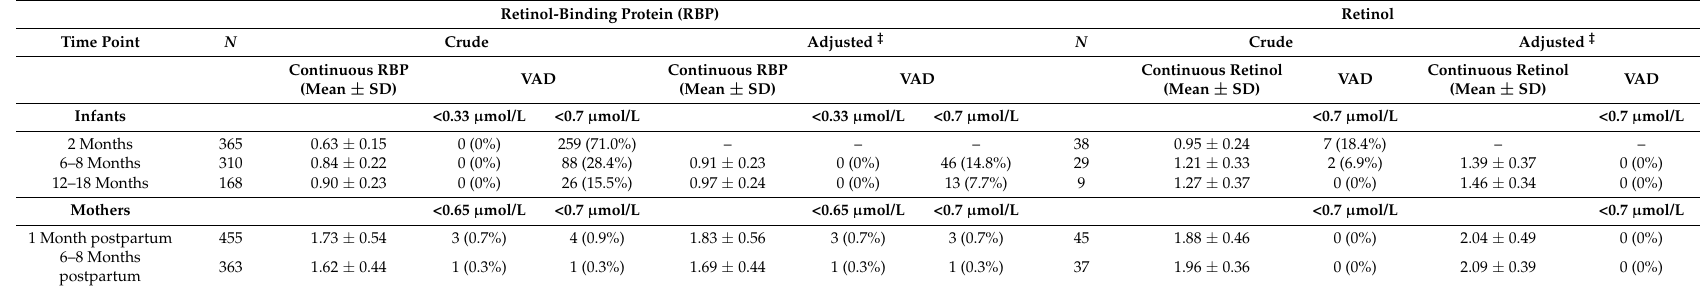
Table 3. Infant and maternal vitamin A status by biomarker and cut-off at different time points.